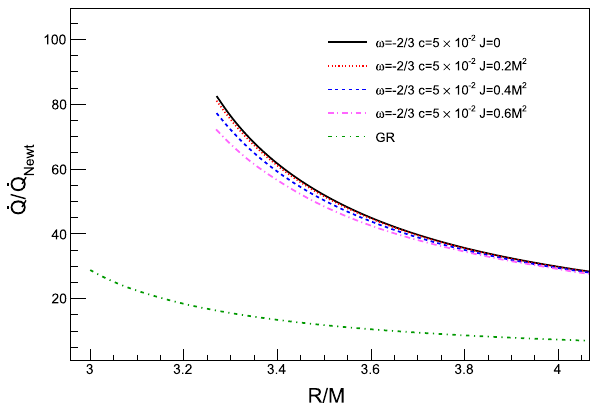
Fig. 8 Ratio of total energy deposition ˙ Q for ω = − 2 / 3 and c = 0 . 05 to total Newtonian energy deposition ˙ Q Newt for four values of the parameter J . The green curve shows the GR energy deposition for